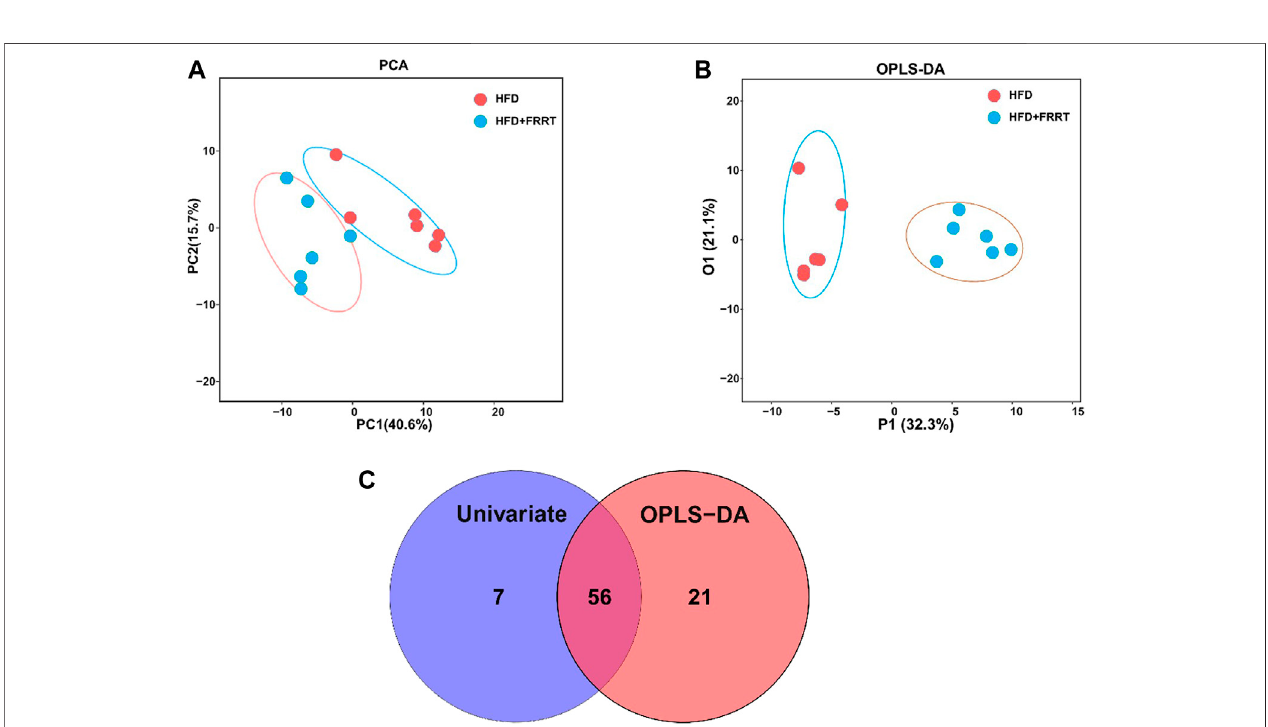
FIGURE4| Metabolicpro fi leaswellasmultivariate/UnivariateanalysisandmetabolicpathwayofmetabolitesbetweenHFDandHFD+FRRTgroup. (A) PCAplots withthescoresofthe fi rsttwoprincipalcomponentsbasedon160metabolites. (B) OPLS-DAplotswiththescoresofthe fi rsttwoprincipalcomponents. (C) VennPlotof differential metabolites, by getting union/intersection of the differential metabolites from univariate statistics and multi-dimensional statistics. (D) Heatmap analysis of potential biomarkers, the concentration value is converted to Z-score by standardized Z-score transformation.